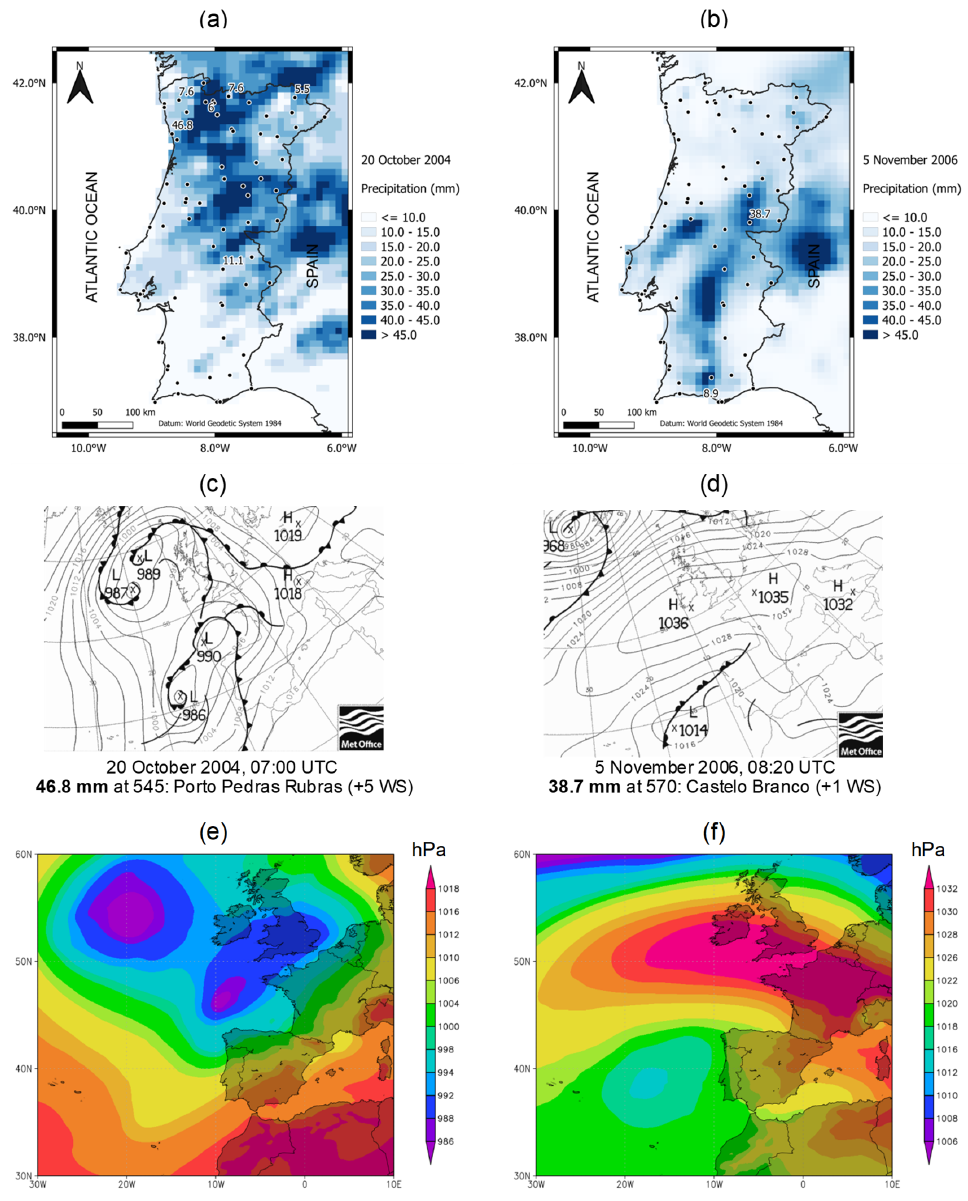
Figure 4. ( a , b ) Location and 10-minute total precipitation (in mm) of all SHHP events in each day, overlaid by the corresponding IBERIA01 daily precipitation (0.1° grid, in mm). ( c , d ) Synoptic analysis charts at 00:00 UTC for the two severest SHHP events (20 October 2004 and 5 November 2006). The UTC hour of the event, the recorded precipitation amount, and the WS, as well as the number of other WS recording an SHHP on the same day, are also indicated. Synoptic analysis charts are provided by the Met Office (metoffice.gov.uk). ( e , f ) Corresponding ERA5 SLP patterns (in hPa) at the day and exact hour of the event (07:00 UTC and 08:00 UTC,